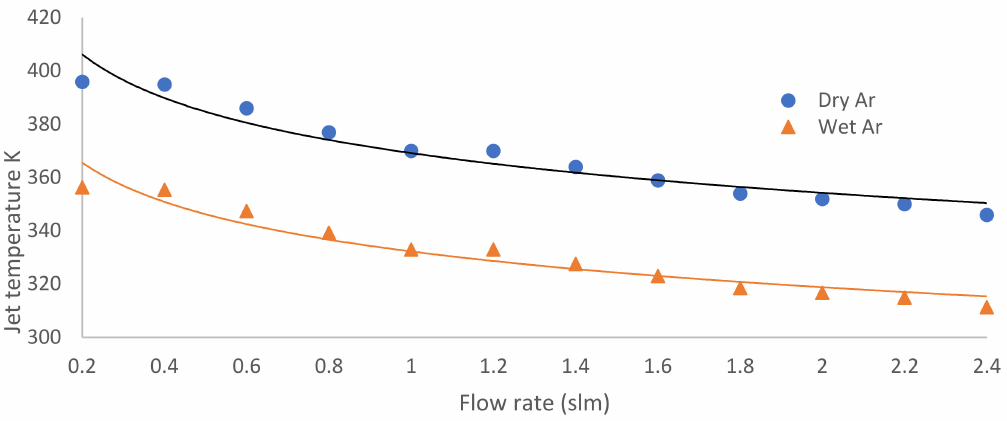
Figure 2. Flow rate influence from 0.2 to 4 slm on the jet temperatures for dry and wet argon